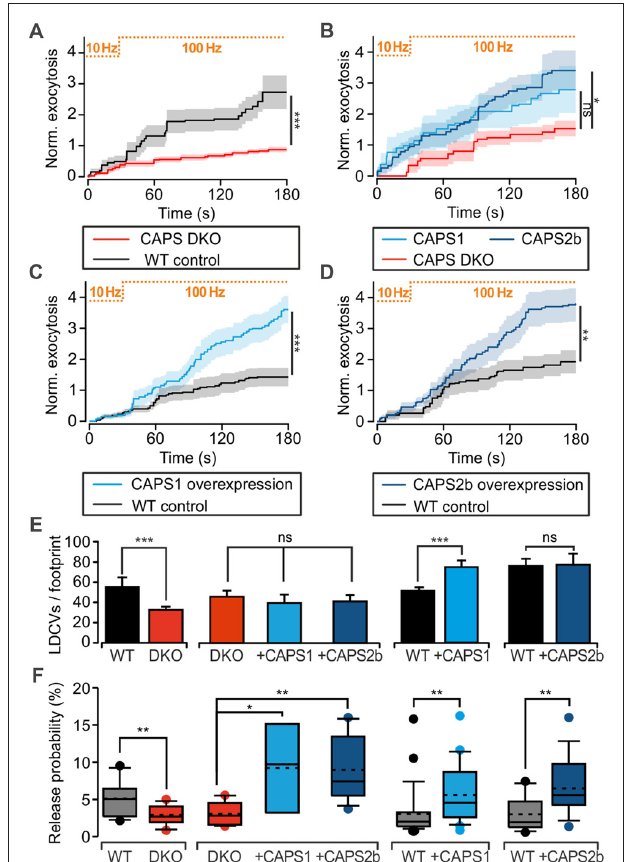
FIGURE 2 | CAPS promotes large dense-core vesicle (LDCV) secretion in DRG neurons. (A–D) Measurement of LDCV exocytosis. LDCVs were labeled via neuropeptide Y (NPY)-Venus overexpression and visualized using TIRFM at 10 Hz. Their exocytosis was evoked via field electrode stimulation. The protocol consisting of a 30-s pre-stimulus at 10 Hz followed by a 100 Hz stimulus is illustrated at the top of each graph. LDCV exocytosis is displayed as the average cumulative exocytosis normalized to the cell footprint area. The graphs include only the cells that responded to the stimulus with LDCV exocytosis. Error bars are SEM. (A) CAPS DKO E18 DRG neurons exhibited defective LDCV secretion compared to E18 WT neurons (N pups = 5 for WT and 6 for CAPS DKO, n neurons = 16 and 18 for WT and CAPS DKO, respectively). (B) Overexpression of CAPS2 rescued LDCV secretion in E18 CAPS DKO neurons (N pups = 10 E18 embryos, n neurons = 10, 8, and 12 for CAPS DKO, CAPS DKO expressing CAPS1, and CAPS DKO expressing CAPS2, respectively). (C) CAPS1 overexpression in adult WT neurons strongly enhanced LDCV secretion (N mice = 5, n neurons = 26 and 23 for WT and WT overexpressing CAPS1, respectively). (D) CAPS2 overexpression in adult WT neurons induced a robust increase in LDCV secretion (N mice = 7, n neurons = 18 and 15 for WT and WT transfected with CAPS2, respectively). Note that secretion in adult WT neurons (panels C,D ) was lower than that in E18 WT neurons (panel A ). (E) Average number of LDCVs visible in the evanescent field normalized to the cell footprint area. Error bars are SEM. (F) Box plot of LDCV release probability, which was calculated by dividing the number of fusion events by the total number of LDCVs at the footprint of the neurons presented in panels (A–D) . The stippled and solid lines in the box correspond to the average and median release probability, respectively. The Mann-Whitney significance test was applied for all graphs except for (B) and the second plot in (E,F) , in which an ANOVA on ranks with Dunn’s post significance test was applied; ∗ p < 0.05, ∗∗ p < 0.01, ∗∗∗ p < 0.001, ns (not significant) p >